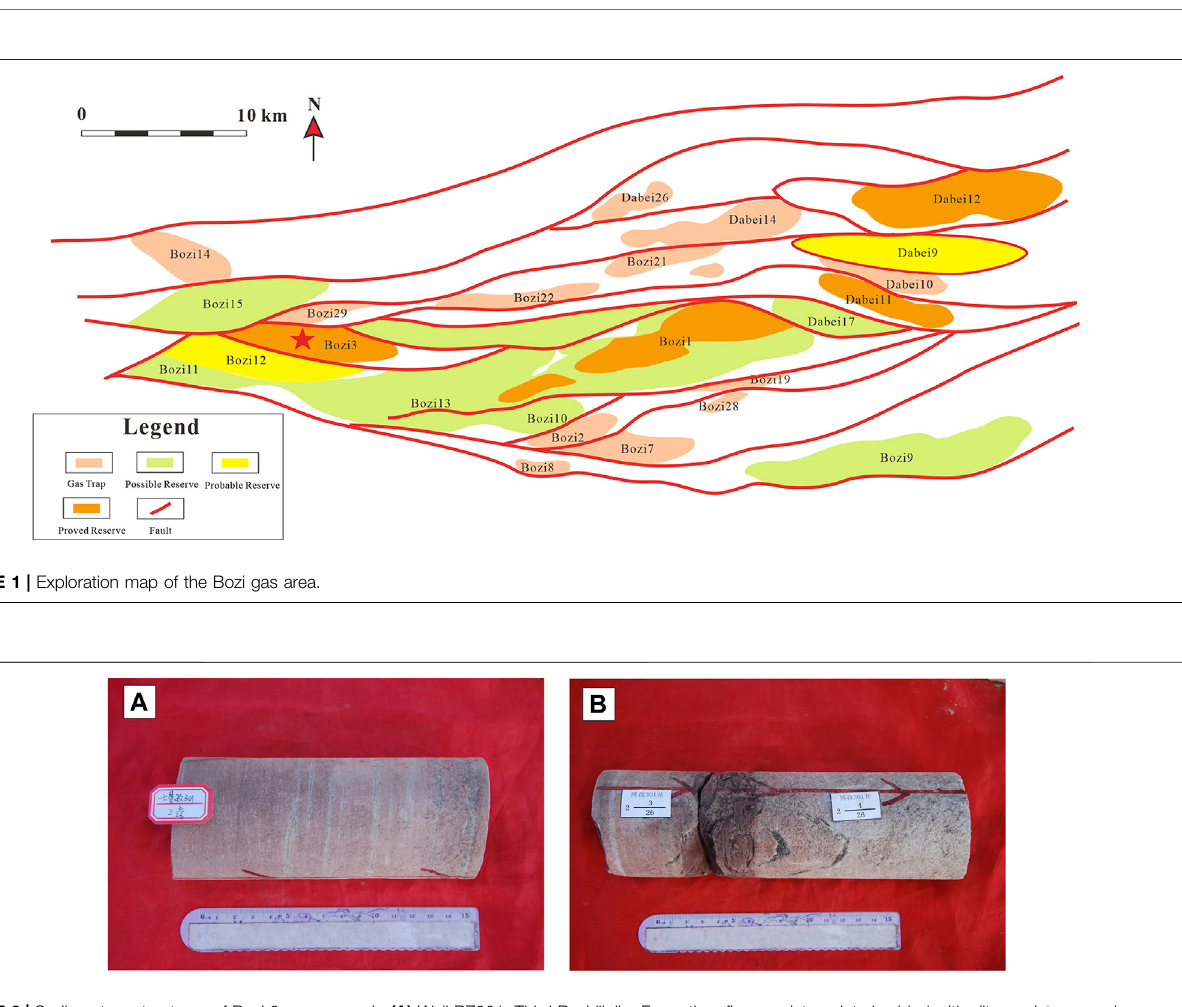
FIGURE 2 | Sedimentary structures of Bozi 3 gas reservoir. (A) Well BZ301, Third Bashijiqike Formation, fi ne sandstone interbedded with silty mudstone, and parallelbeddingand crossbedding structure canbeseen; (B) WellBZ301, ThirdBashijiqikeFormation, medium to fi nesandstone,andinterbedded withmudstone and mud-graveled sandstone can be seen with erosion surface structure on the